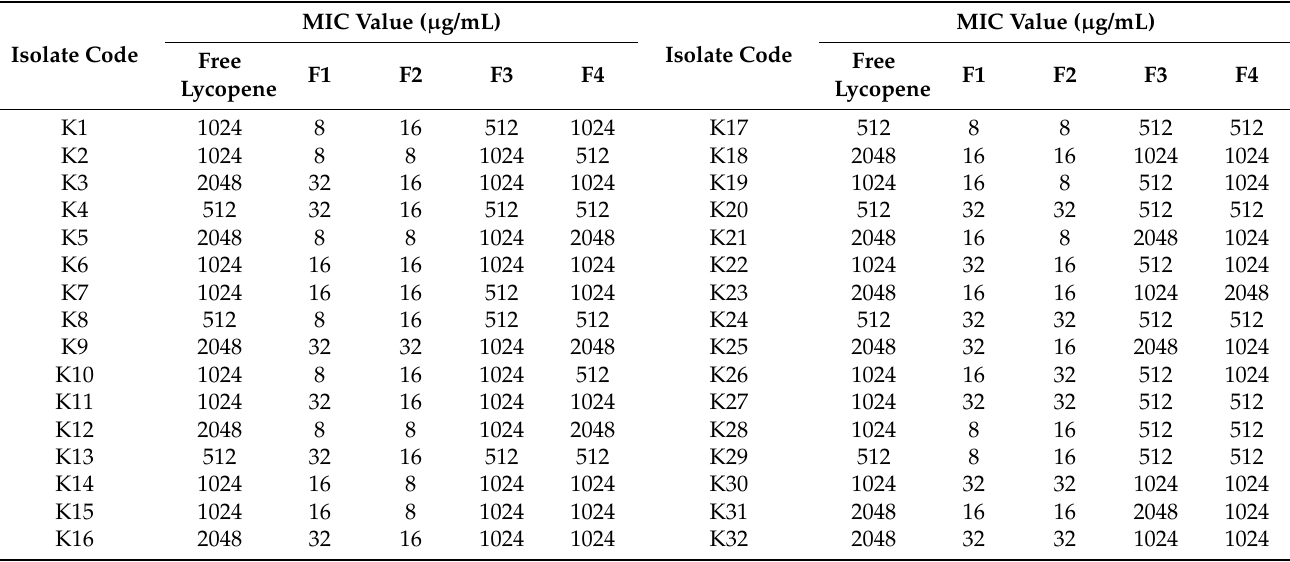
Table 4. MIC values of free lycopene and its